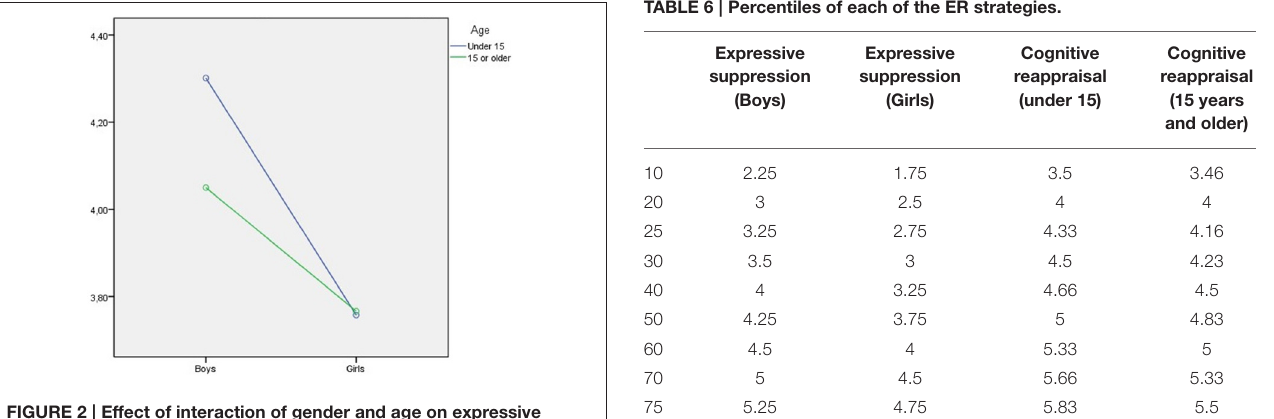
FIGURE 2 | Effect of interaction of gender and age on expressive suppression strategy.